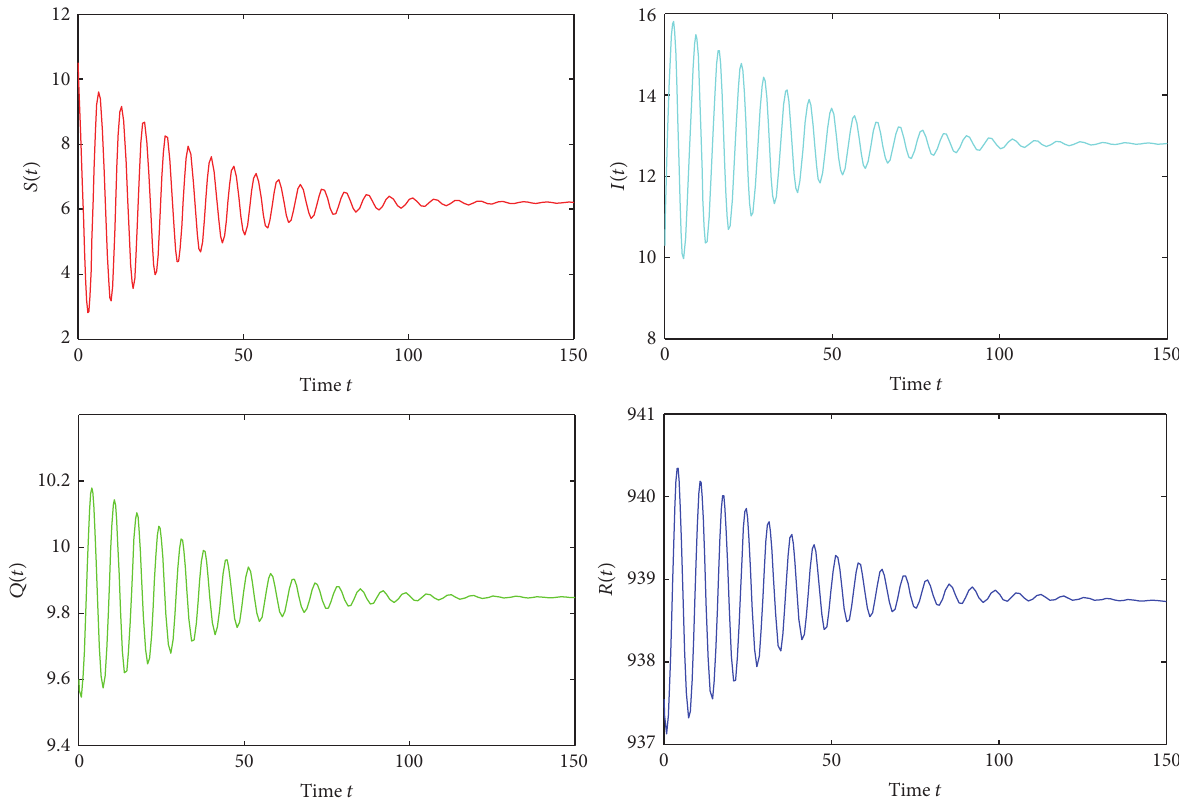
Figure 1: The trajectory of 𝑆 , 𝐼 , 𝑄 , and 𝑅 when 𝜏 1 = 1.3025 < 1.3265 = 𝜏 10 .